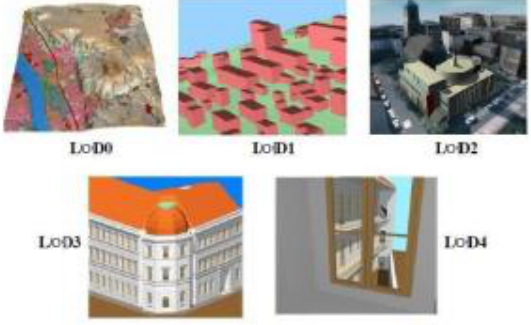
Figure 2. LoDs of CityGML (Gröger et al.,